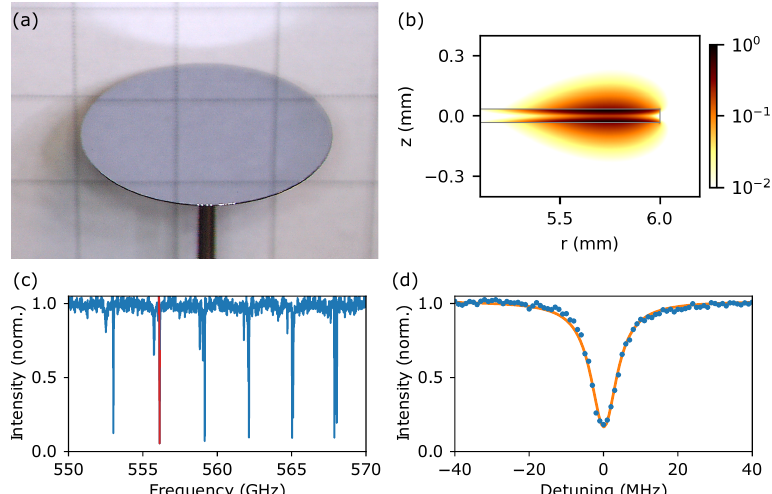
Figure 1. ( a ) Microscope image of a 12mm diameter, 66 ± 1 µ m thick HRFZ-Si THz disc microresonator. The resonator is mounted on a 1mm diameter aluminium rod. ( b ) Corresponding simulated intensity distribution (normalised) on logarithmic scale showing the large extend of the evanescent field. The microresonator cross-section is indicated with grey lines. Please note that all simulations presented in this work are performed with COMSOL Multiphysics ® software [32], and fabrication imperfections are not considered in the simulations. ( c ) Measured intensity profile of the THz disc microresonator showing the fundamental mode. ( d ) Resonance at 0.5561THz (highlighted in red in sub-figure (c)) close to critical coupling. The frequency step size is 1 MHz (blue dots). The fitted analytical model [33] is shown with the orange solid